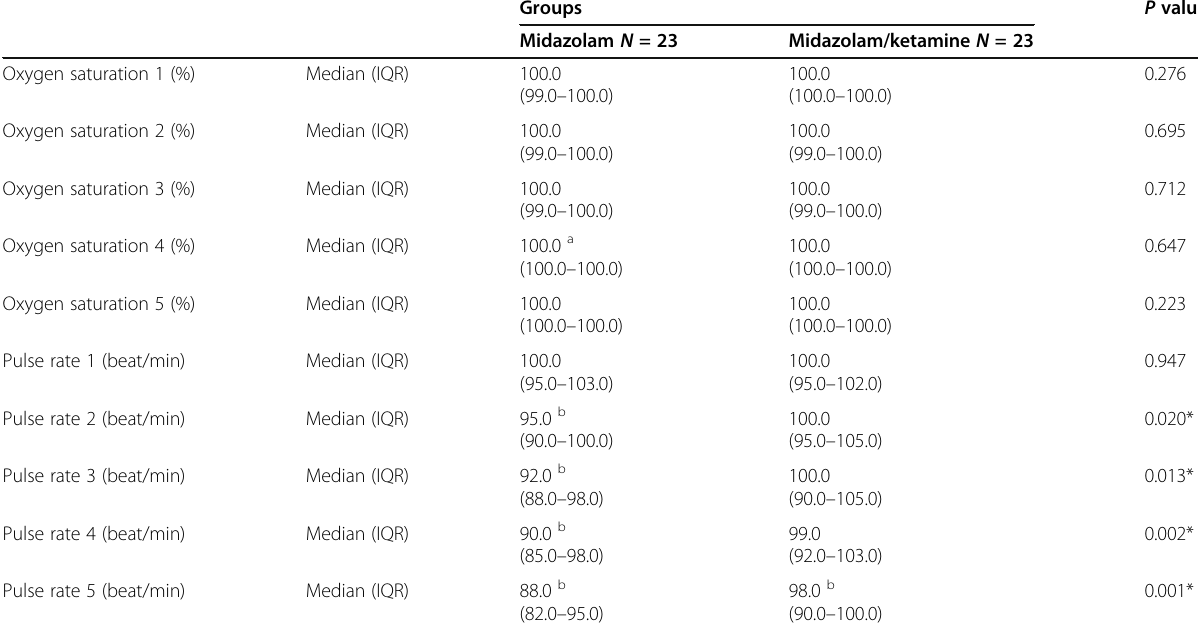
Table 3 Comparison of the secondary outcomes between the studied groups